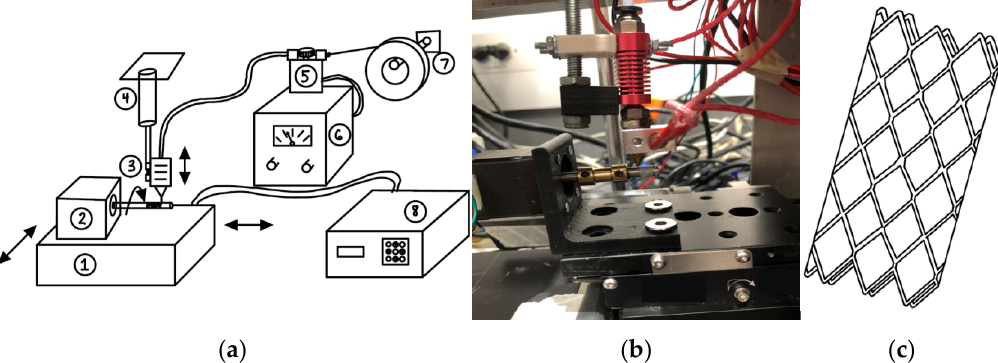
Figure 1. ( a ) Schematic of in-house fabrication unit of flow diverting stent (FDS) shows different parts of the unit as follows: Micro-motion stage with two degrees of freedom (1), rotary arm FDS forming platform (2), electromelt needle (3), vertical micromotion stage (4), polycaprolactone (PCL) feed rate controller (5), variable power supply (6), filament spool hanger (7) and micro-motion controller unit (8); ( b ) the actual fabrication unit and ( c ) schematic of the PCL FDS.